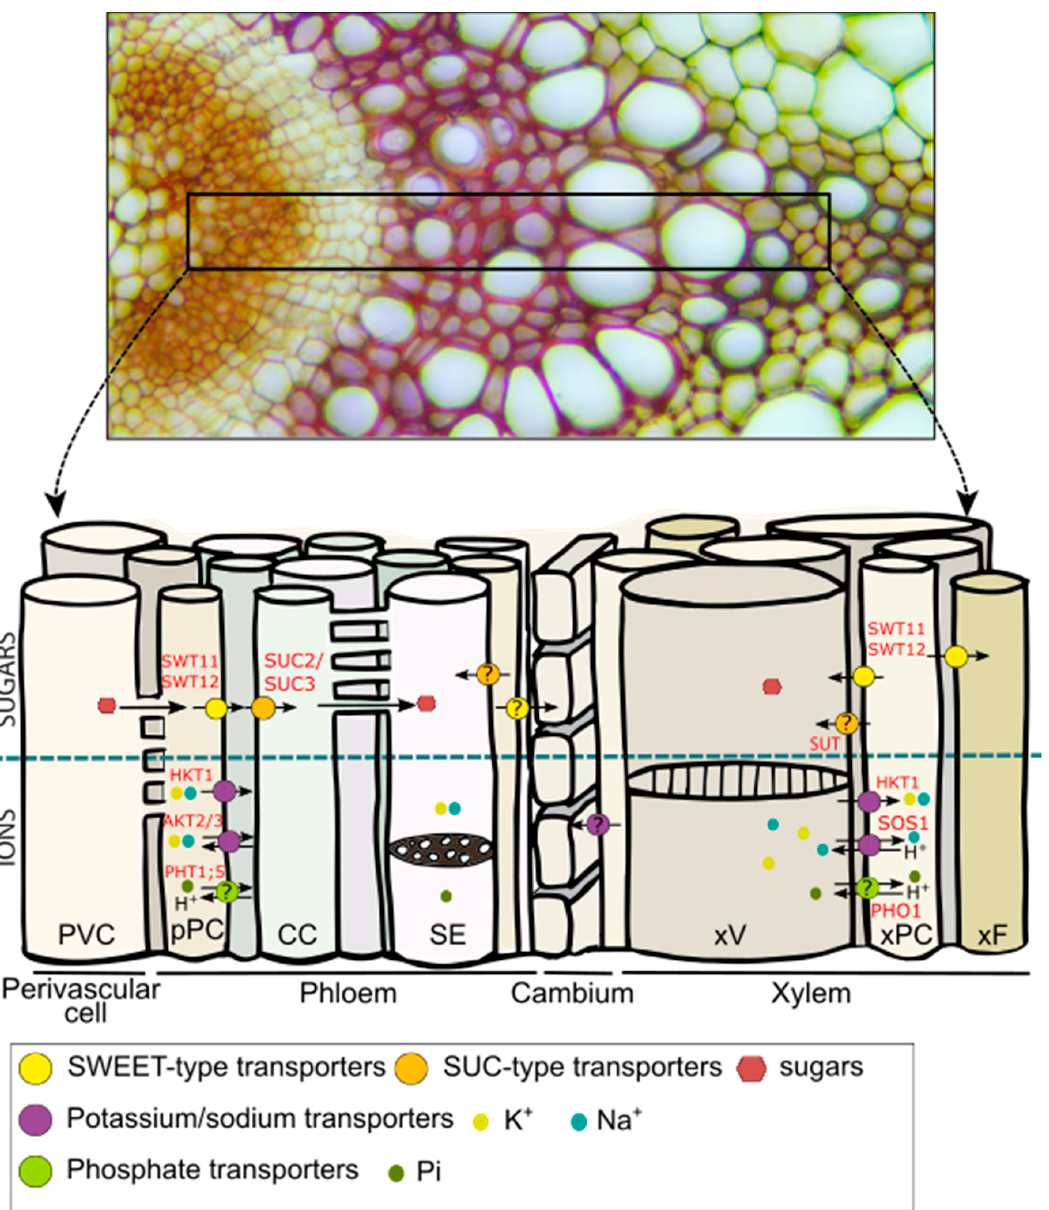
Figure 2. Model for sugar and ion transport in the Arabidopsis floral stem. The upper panel shows a vascular bundle transversal section stained with alcian blue/safranin O. The primary cell walls appear in different shades of orange and the secondary cell walls appear in red. The lower panel is a sketch showing a longitudinal view of the different cell types present in a vascular bundle. The white bridges between two cells represent the plasmodesmata. The model was based on current knowledge of the spatial distribution of sugar and ion transporters in the Arabidopsis floral stem. Known locations of members of the sugar and ion transporters in other Arabidopsis organ or in woody stem have been added as putative locations in Arabidopsis floral stem (question marks). pPC: phloem parenchyma cell; CC: companion cell; SE: sieve element; SUC: SUCROSE TRANSPORTER; SWEET: SUGAR WILL EVENTUALLY BE EXPORTED TRANSPORTERS; xV: xylem vessel; xF: xylary fiber; xPC: xylem parenchyma cell.